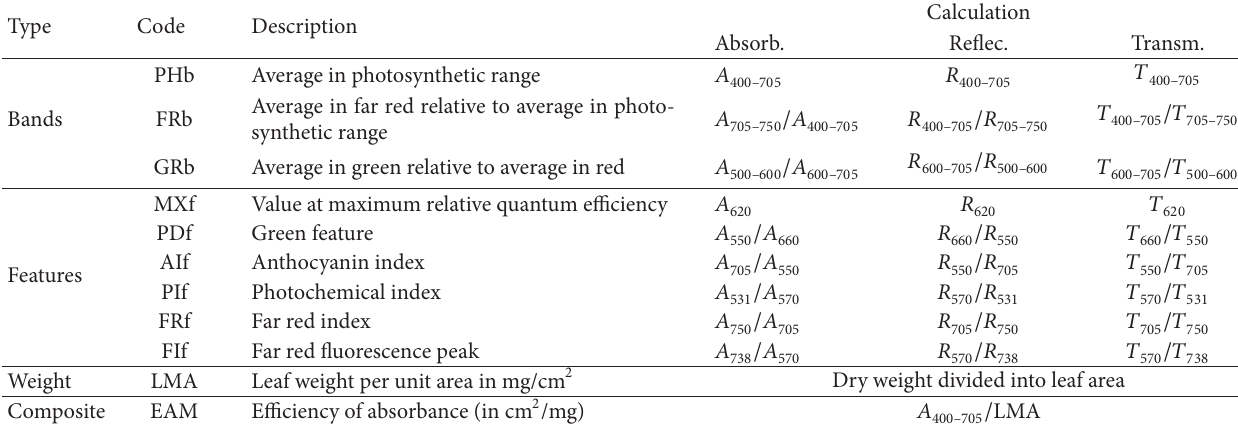
T 2: Summary of variables selected for